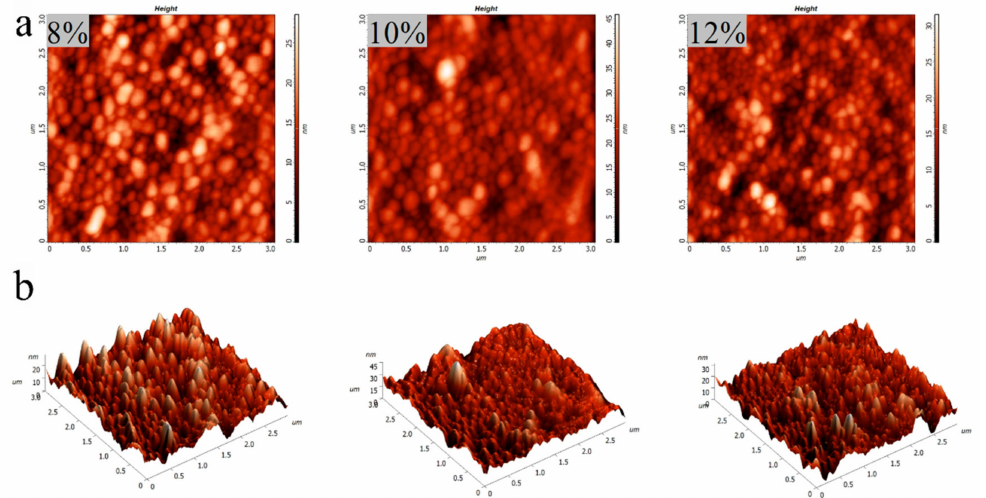
Figure 5. AFM (3 µ m × 3 µ m) topography ( a ) and three-dimensional ( b ) images of GNPs cross-linked by di ff erent genipin dosages (8~12